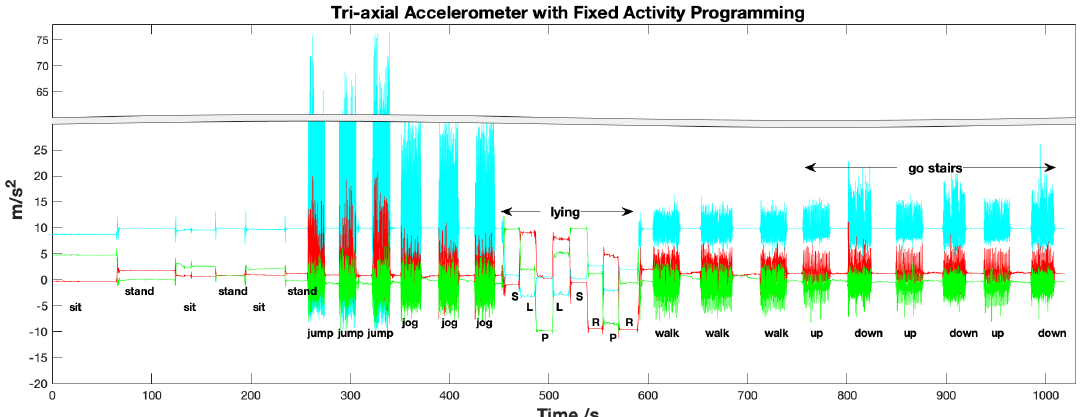
Figure 2. The schematic diagram of labeled 12 activities on the collected 3-axis acceleration